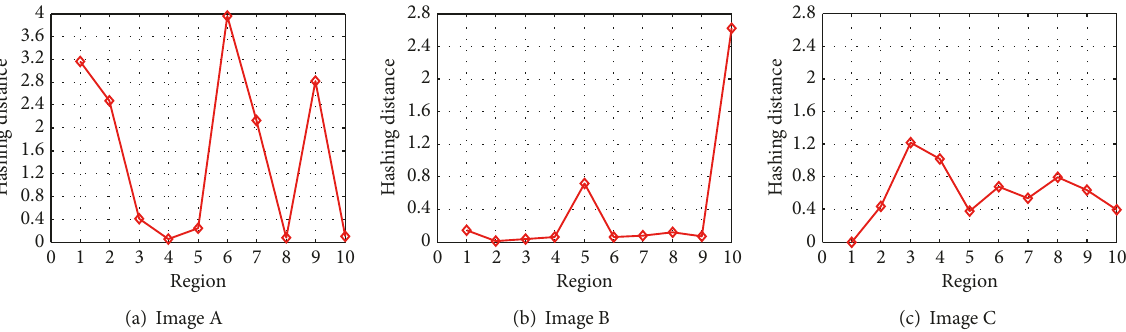
Figure 4: Hashing distance for different regions with perceptual saliency corresponding to three images in Figure